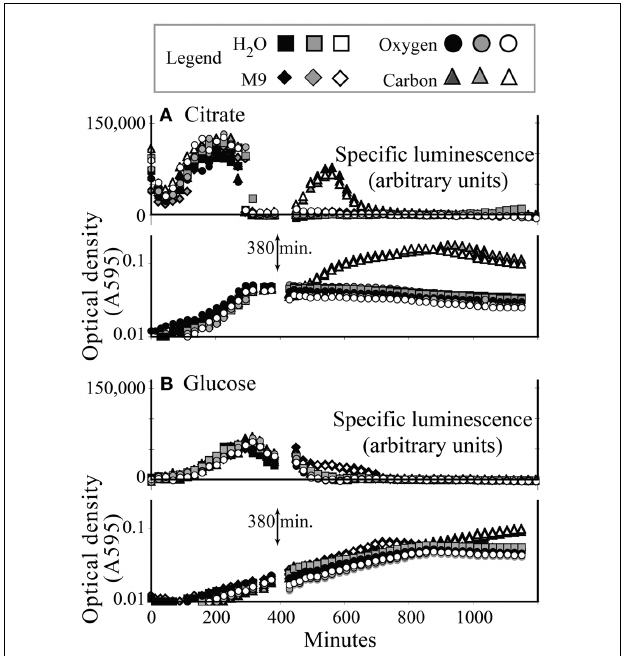
FIGURE 4 | Induction of specific luminescence from microbiosensor KT2440/pZKH2 during growth in citrate (A) or glucose (B), in 48-well plates. At 380min., triplicate wells were spiked with carbon, oxygen, M9 medium, or water. Growth and luminescence data are separated for clarity. Each replicate is shown separately.